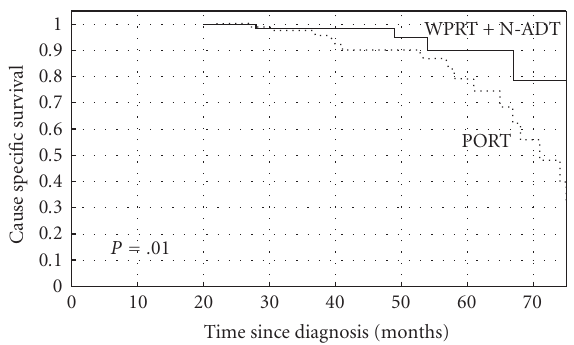
Figure 2: The Kaplan-Meier curves comparing cause specific survival (CSS) for patients at high-risk of nodal involvement, as defined in text receiving whole pelvic radiotherapy (WPRT) combined with neoadjuvant androgen deprivation therapy (N- ADT) or prostate radiotherapy only (PORT), ( P = . 01).